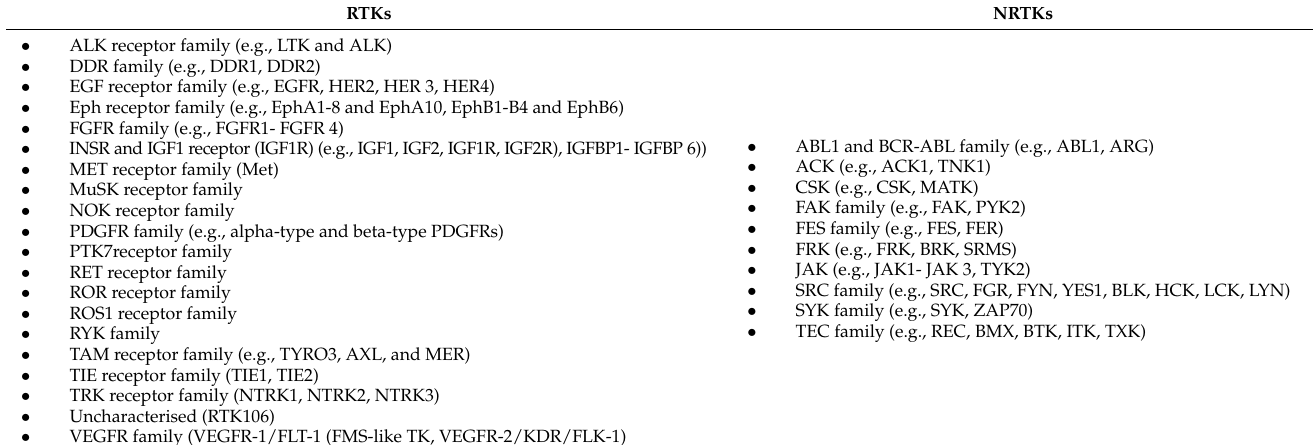
Table 1. Receptor and nonreceptor Classes of tyrosine kinase (TK) families. RTKs